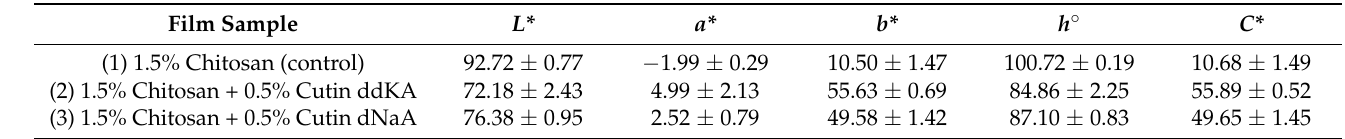
Table 10. Measured color parameter values: lightness ( L *), chromaticity coordinates ( a * and b *), and calculated hue ( h ◦ ) and chroma ( C *) of the selected film